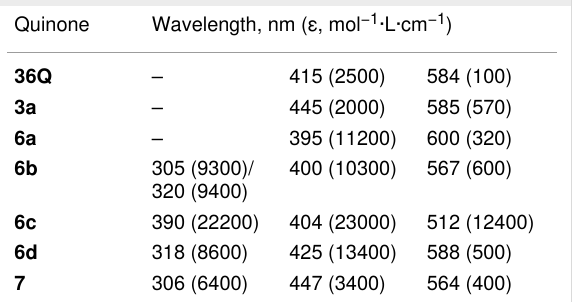
Table 2: UV–vis absortption spectra data of o